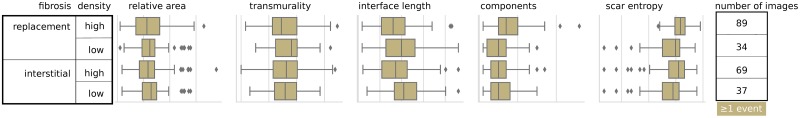
Distribution of scar feature values for various microstructure types.Microstructure types are classified as interstitial or replacement, and high (max density 0.8-1.0) or low (max density 0.4-0.6) density. Each data point represents an image whose models experienced at least one event (reentry or block) for a particular microstructure type.